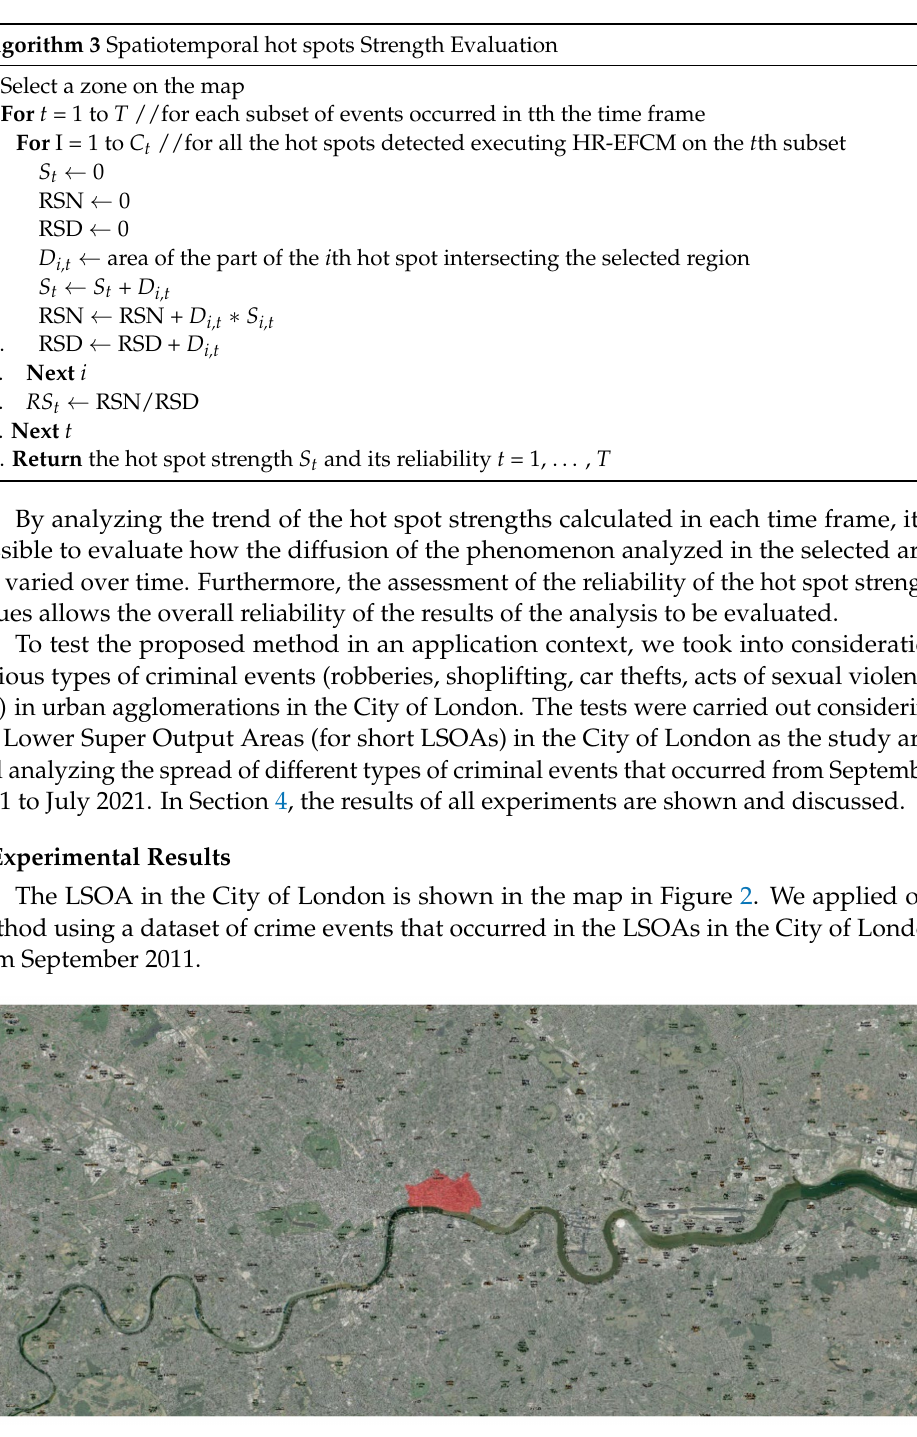
Figure 2. LSOAs of the City of London, shown within Greater